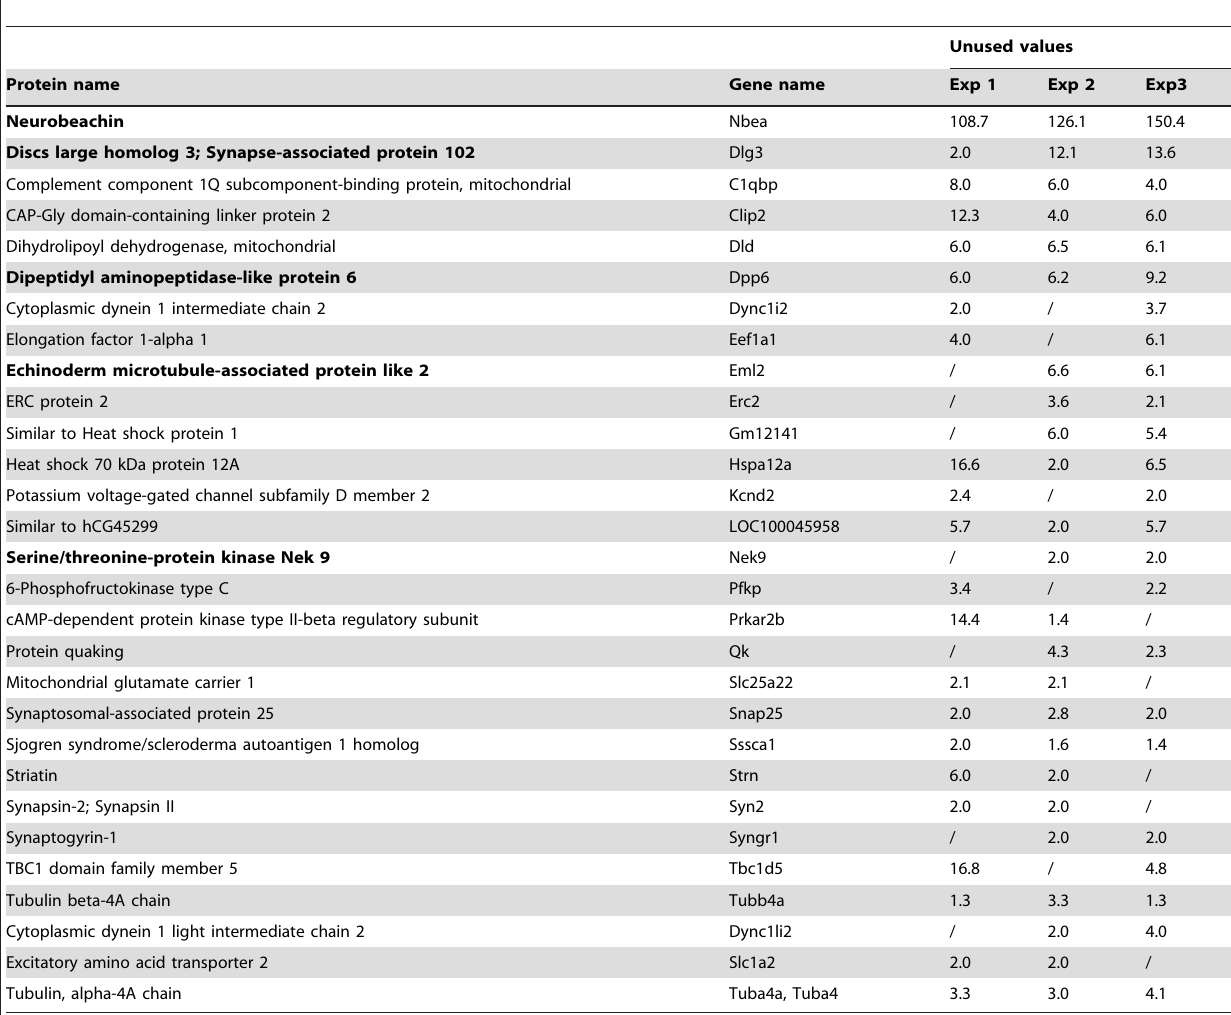
Table 3. List of proteins identified from IPs on P2 + microsomes fraction from P84